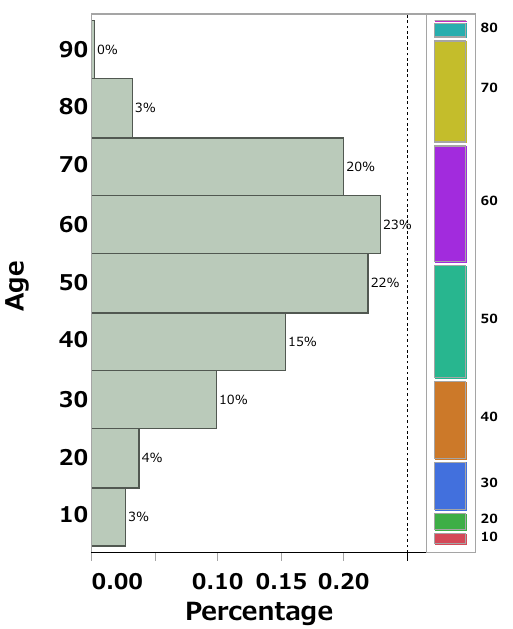
Figure 3. Histogram of age in antibiotic-induced taste and smell disorders. Age was stratified into 10-year groups. The feature of taste and smell disorders peaked in the 60 s (23%), followed by the 50 s (22%), 70 s (20%), and 40 s (15%).